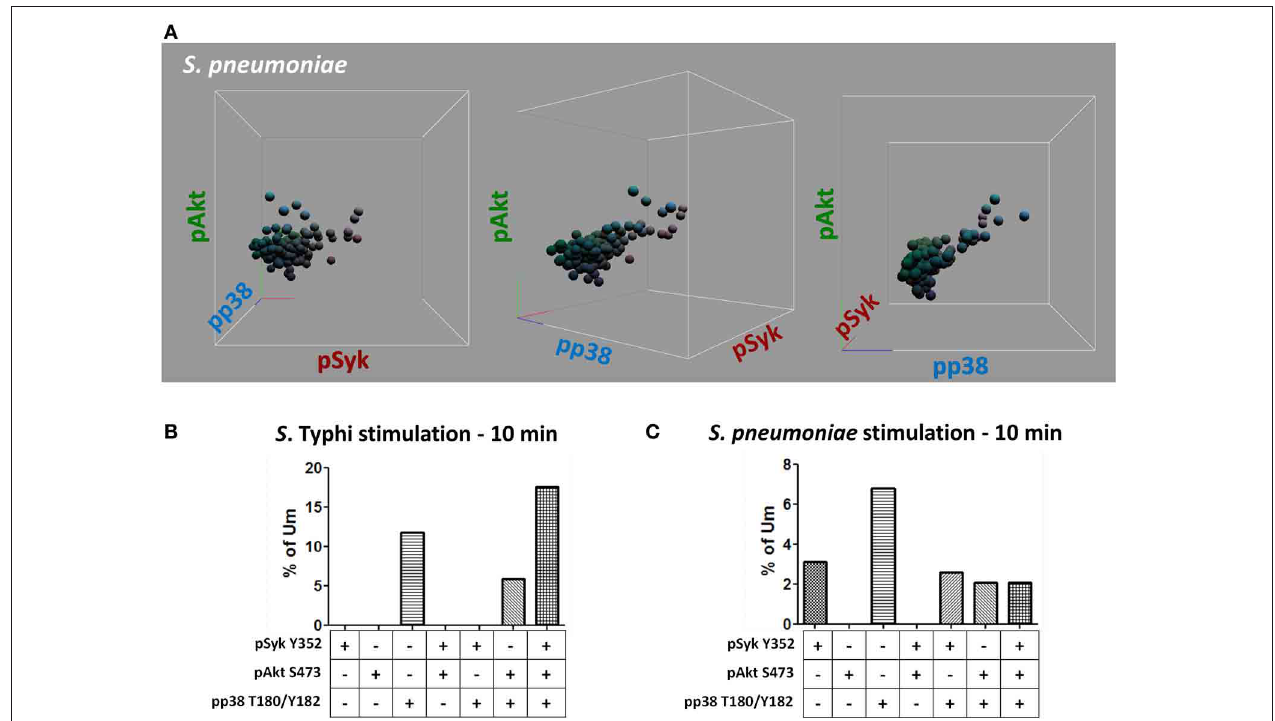
FIGURE 11 | Multiphosphorylated Um B cells. Whether single or multiple proteins were phosphorylated simultaneously (A) was evaluated by gating on Um cells which bound S . Typhi or S. pneumoniae ( B and C , respectively). Multiple tri-dimensional views (rotated on the X axis) from a representative volunteer are displayed (stimulation with S. pneumoniae for 10min) (A) .